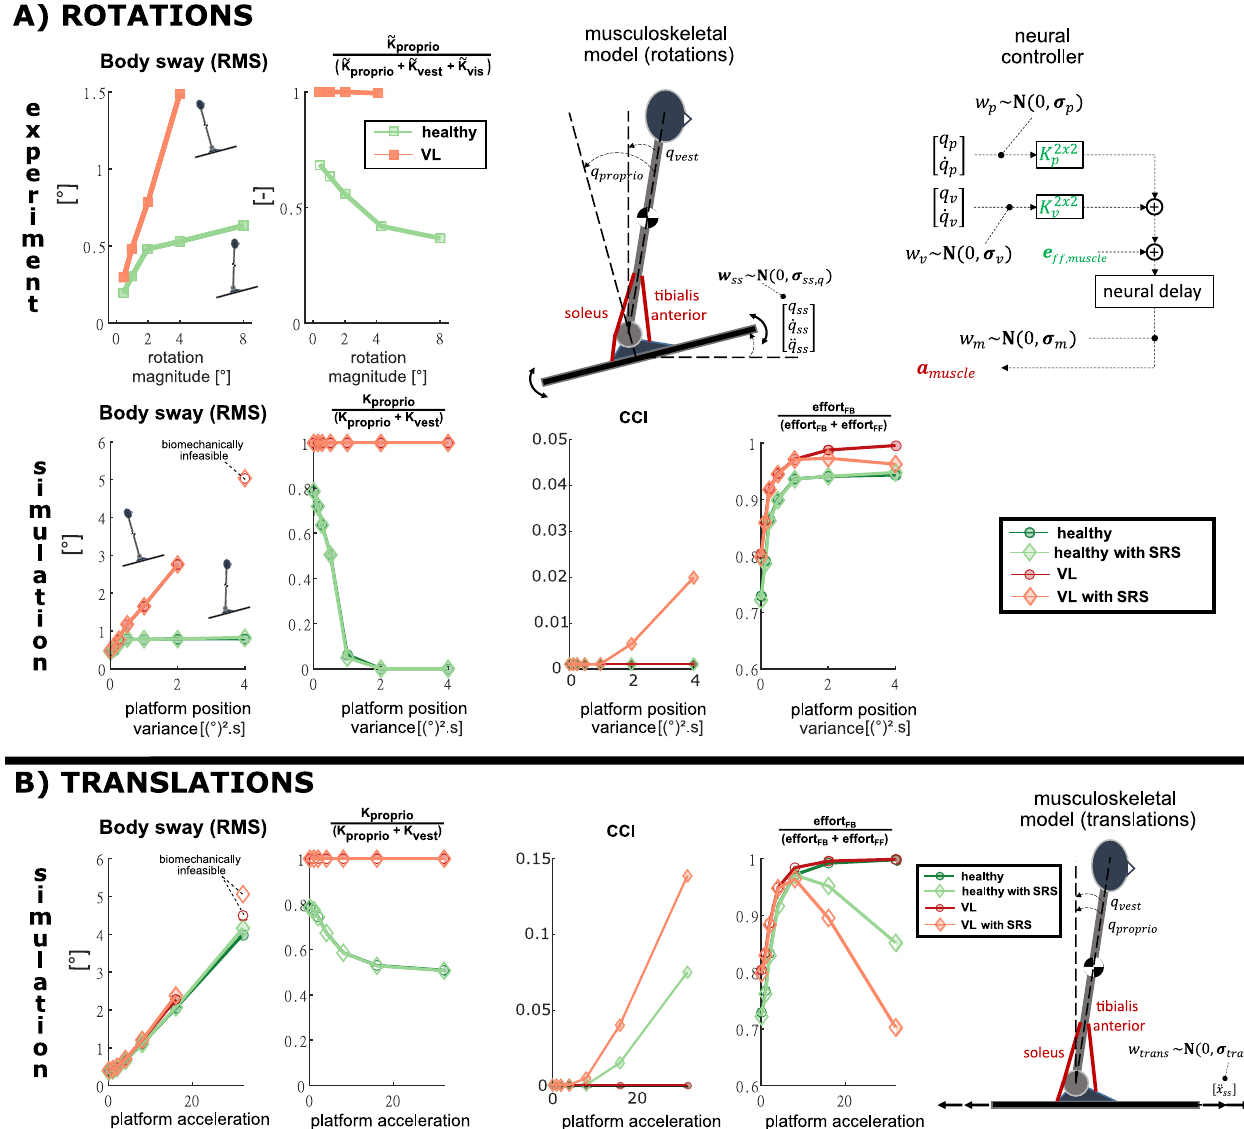
Fig 1. A) ROTATIONS. Musculoskeletal and control model. The proprioceptive (relative angle between the body and platform: q ; _ q ) and vestibular p p (absolute body angle: q ; _ q ) cues encode different information that is corrupted by proprioceptive ( w ) and vestibular noise ( w ). The platform rotations are p v v v modeled by Gaussian noise ( w SS ) of the platform position ( q SS ), velocity ( _ q ) and acceleration ( € q ). a muscle are muscle activations; e ff , muscle are muscle SS SS feedforward excitations that are constant here; K 2 x 2 are proprioceptive feedback gains and K 2 x 2 are vestibular feedback gains. Experiment and simulation . p v Experimental data for body sway and feedback gains are from Peterka et al. [32]. RMS body sway, relative experimental proprioceptive feedback gains k ~ K proprio k and relative simulated proprioceptive feedback gains k ~ K proprio kþk ~ K vest kþk ~ K vis k for healthy and vestibular loss (VL) subjects with and without short-range-stiffness (SRS) modeled. B) feedback to the total expected effort: effort FB ð effort FF þ effort FB Þ TRANSLATIONS . Musculoskeletal model . The control model is identical to the model used to simulate the response to rotation perturbations, but in the case of translation perturbations the relative and absolute body angles are identical and vestibular and proprioceptive cues encode the same information. Platform translations are modeled by Gaussian noise ( w trans ) of the linear platform acceleration ( € x ). Simulation results. Simulation. Same outcome variables as for the SS rotation perturbations are shown.